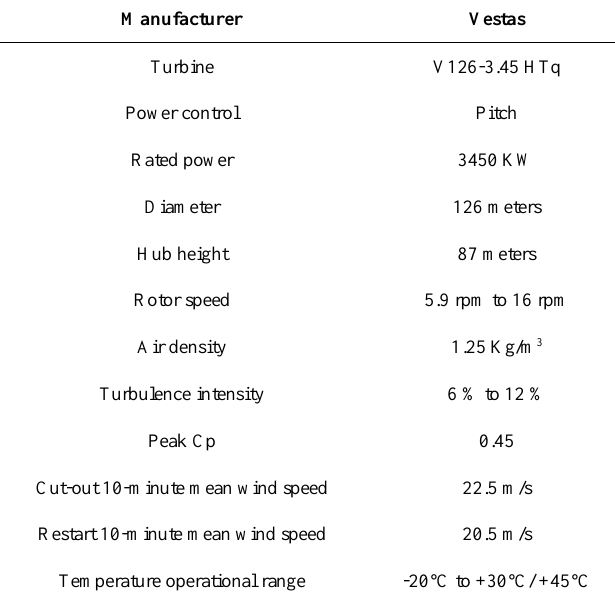
Table 2. The technical specifications of Vestas V126-3.45 HTq